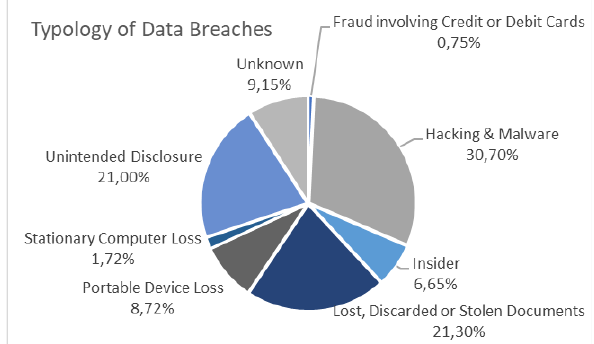
Figure 5. Typology of data breach events between 2010 e 2018 (data source: